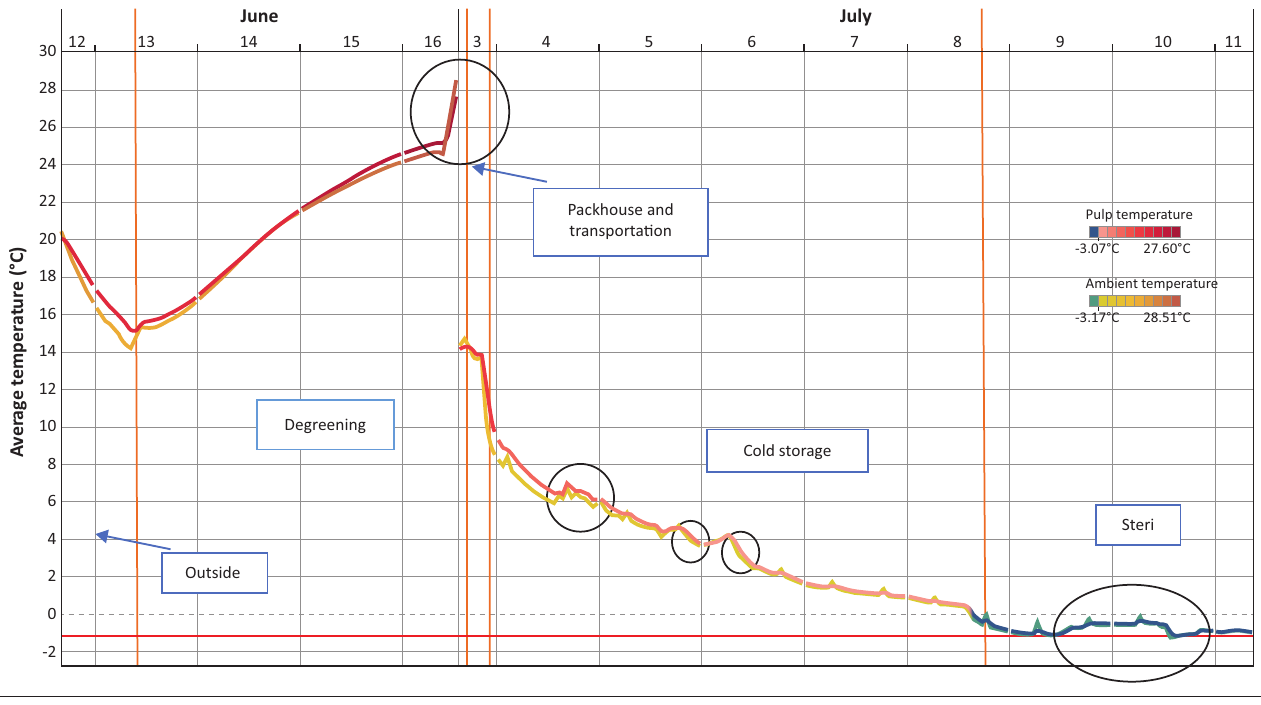
FIGURE 8: Time-series line graph of navels load two: Pulp and ambient